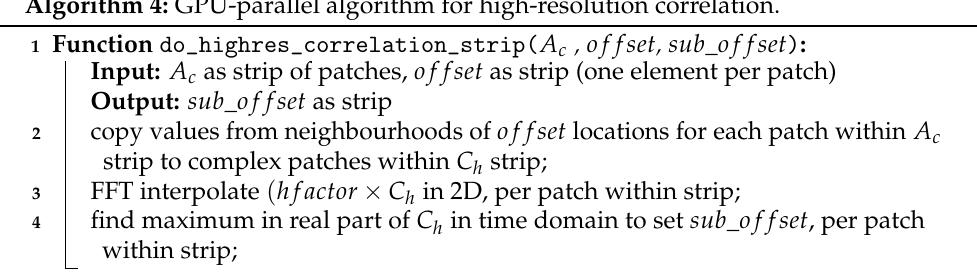
Algorithm 4: GPU-parallel algorithm for high-resolution